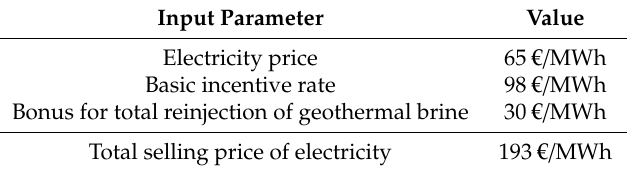
Table 5. Assumption of the economic drivers for the profitability estimation.